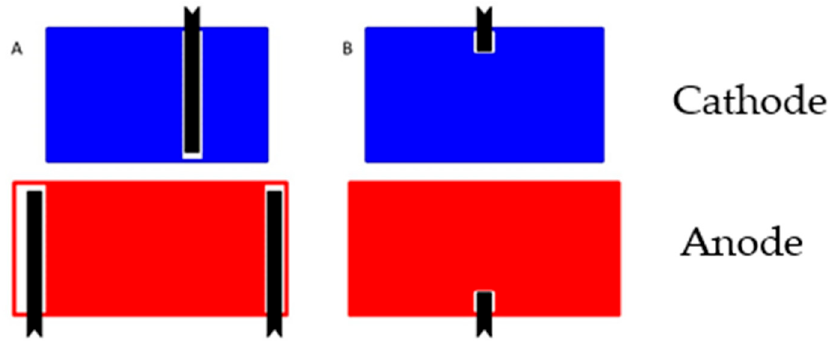
Figure 3. Measured thicknesses for cell components.